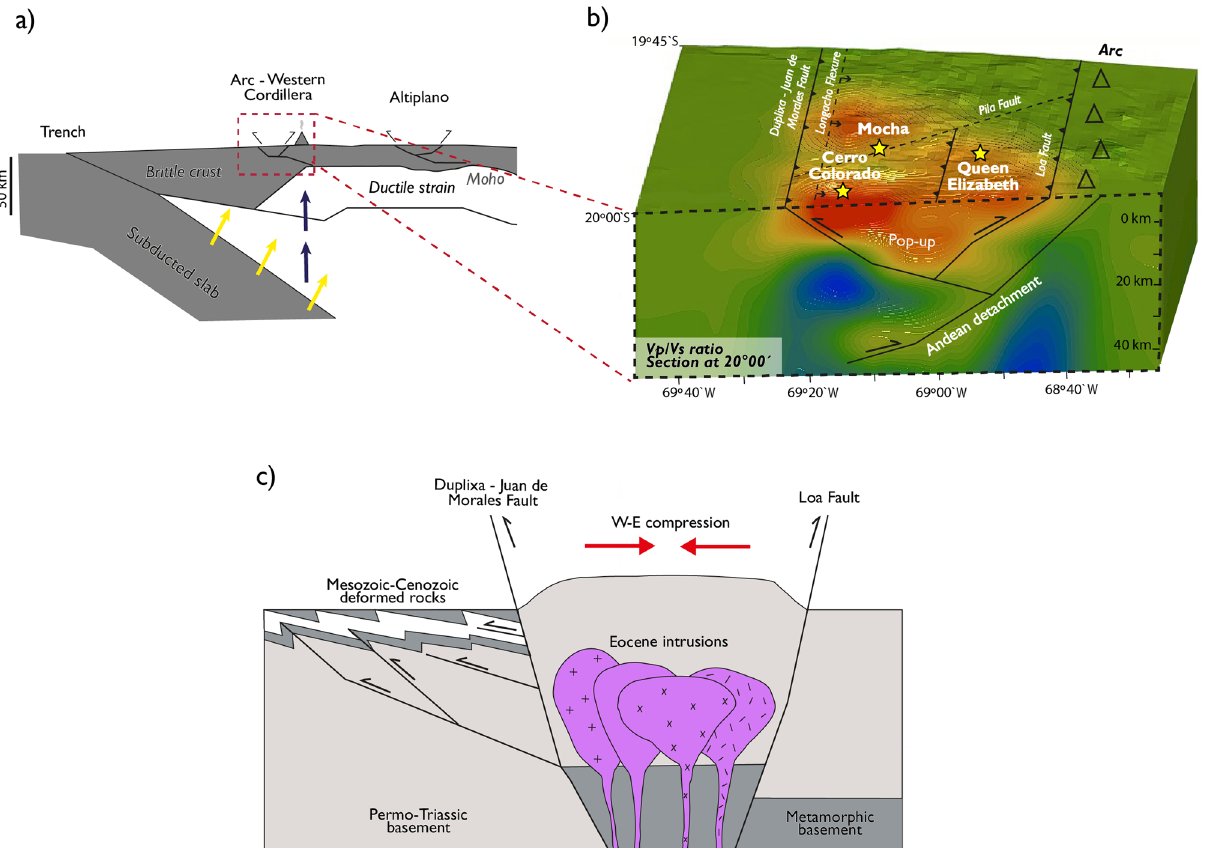
Figure 6. Subsurface architecture beneath the Central Andes subduction zone and the study area. ( a ) Schematic representation of the Central Andean subduction zone based on seismic and magnetotelluric models 13,15 . The subduction slab dehydration (yellow arrows) causes mantle wedge serpentinization and provides the flux needed to lower the melting temperature. At depths of 120–150 km, partial melting of ultramafic mantle rocks occurs yielding to the generation of basaltic magmas (blue arrows). The figure also shows the location of the Western Cordillera magmatic arc. ( b ) Proposed subsurface architecture in the study area based on Vp/Vs model. Figure shows inferred pop-up structures rooted in the Andean east-verging detachment within a regional context dominated by compression 55 . ( c ) Eocene porphyry intrusion emplacement model in a pop-up geometry. Figure ( a ) was generated by the software Adobe Illustrator 2022 (www. adobe. com) and based on Comte et al. 13 . Figure ( b ) was generated by Leapfrog 2022.1 (www. seequ ent. com) and the final editing was done with Adobe Illustrator 2022 (www. adobe. com). Faults distribution are based on Valenzuela, et al. 24 . Figure ( c ) was